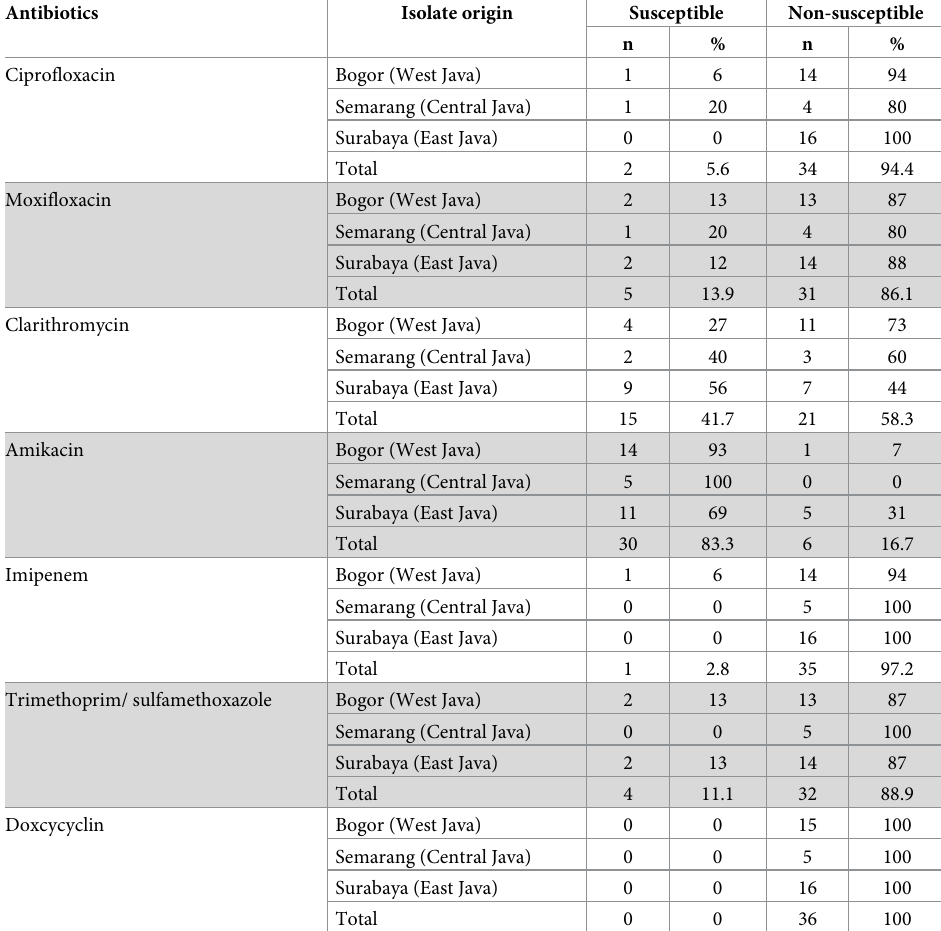
Table 3. Test results of M . abscessus susceptibility assay to various antibiotics. Antibiotics